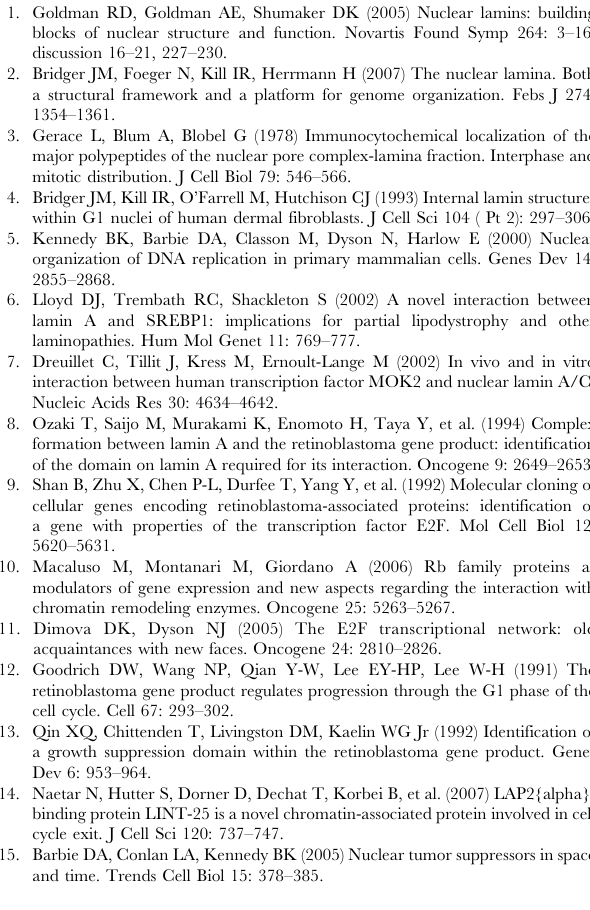
Figure S2 QPCR analysis comparing the mRNA’s of gankyrin in Lmna-/- myoblasts. -/- cells are derived from the Lmna-/- mouse. + / + cells are the litter-mate control cells, which possess endogenous lamin A/C. siLmna cells are NIH3T3 cells with siRNAs targeted to Lmna. siGFP cells are NIH3T3 cells with siRNAs targeted to a control gene, enhanced GFP. Gankyrin mRNA’s are increased four-fold in Lmna-/- fibroblastss and siLmna cells, compared to the control cells. Lmna-/- myoblasts possess similar gankyrin mRNA levels as Lmna + / + myoblasts. Data represent averages of triplicate experiments performed and mRNAs were normalized against